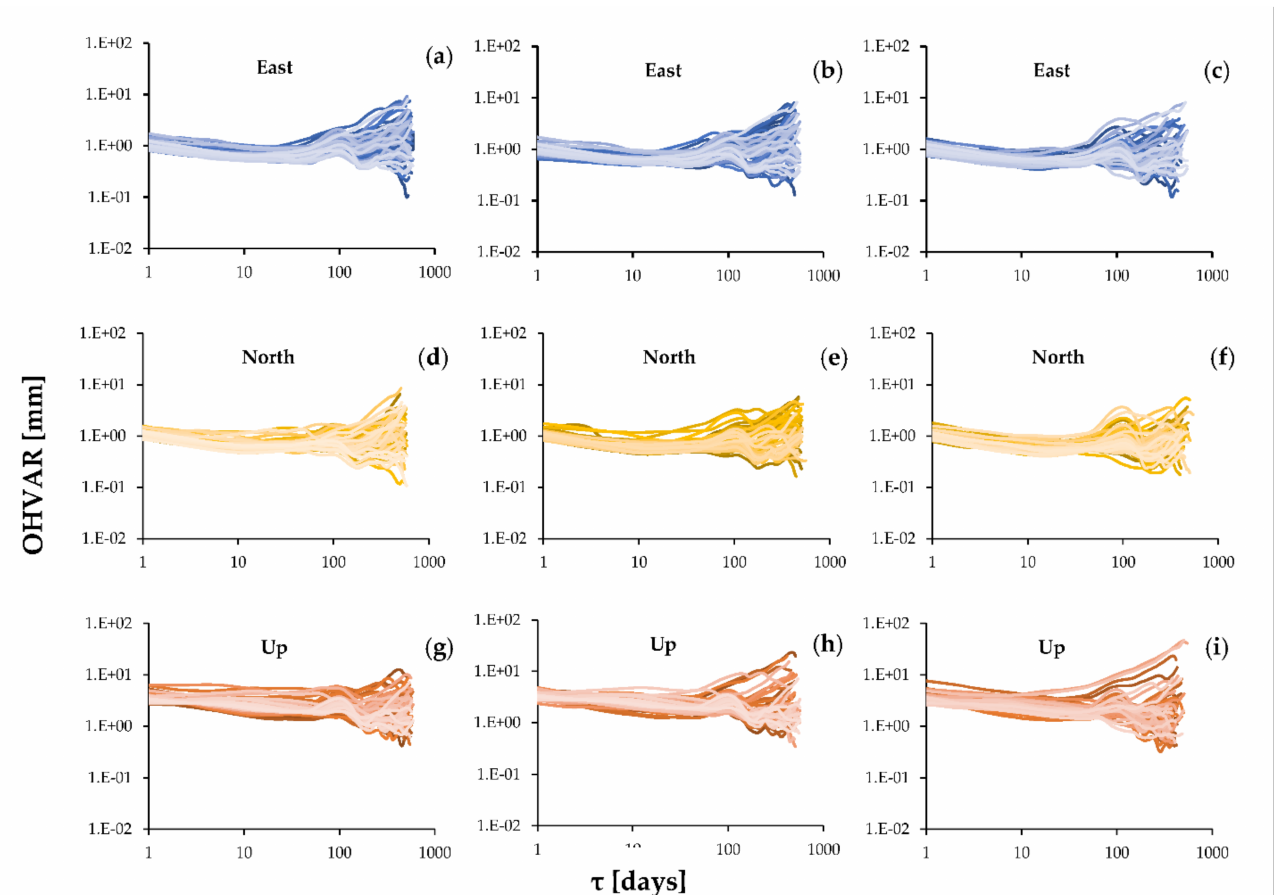
Figure 7. ( a – i ) OHVAR of each coordinate component for the three periods analysed: 1995–1999 (left column), 2000–2004 (centre) and 2005–2009 (right